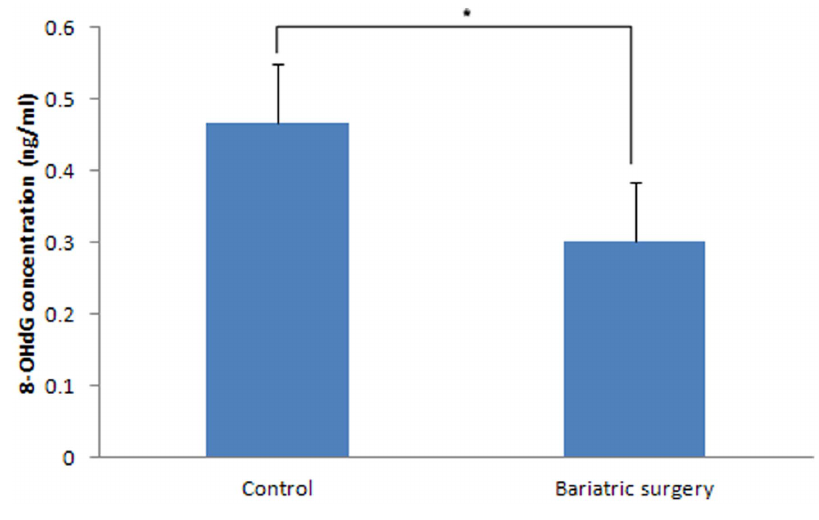
Figure 8. 8-OHdG concentration between the control and bariatric surgery groups (*: p=0.016).